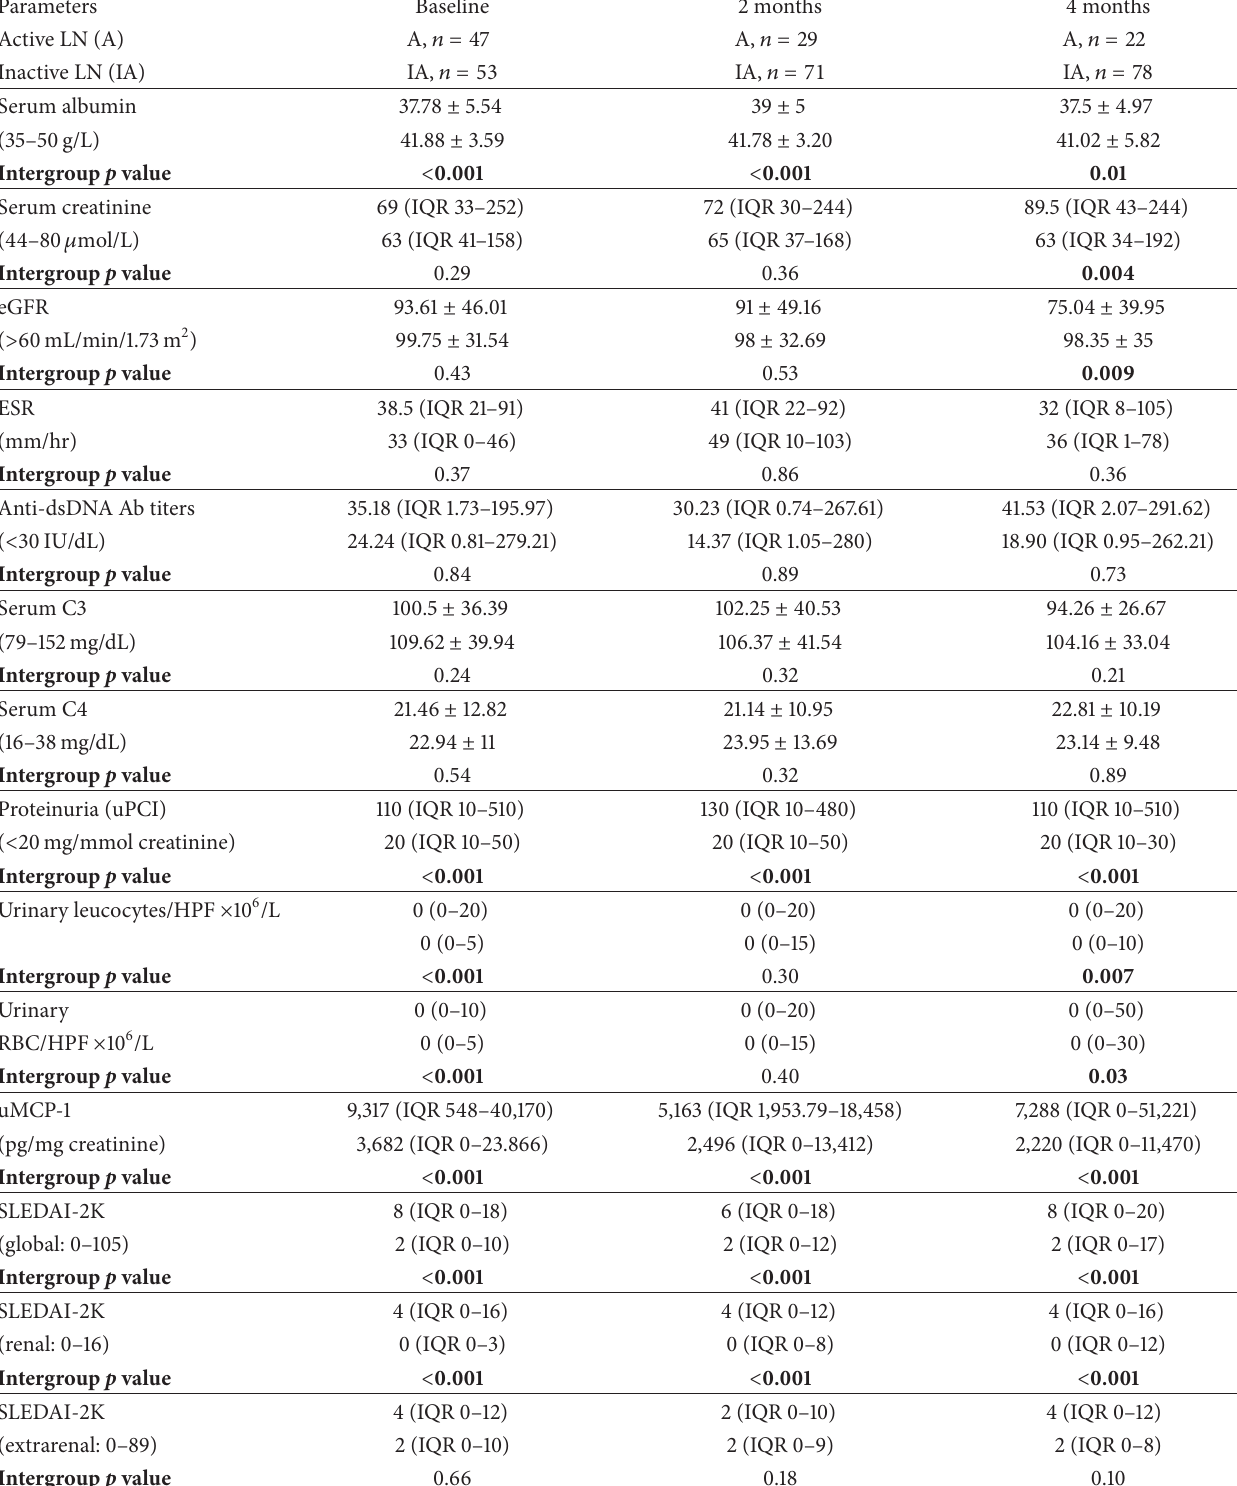
Table 3: Characteristics of patients with active and inactive LN at each time